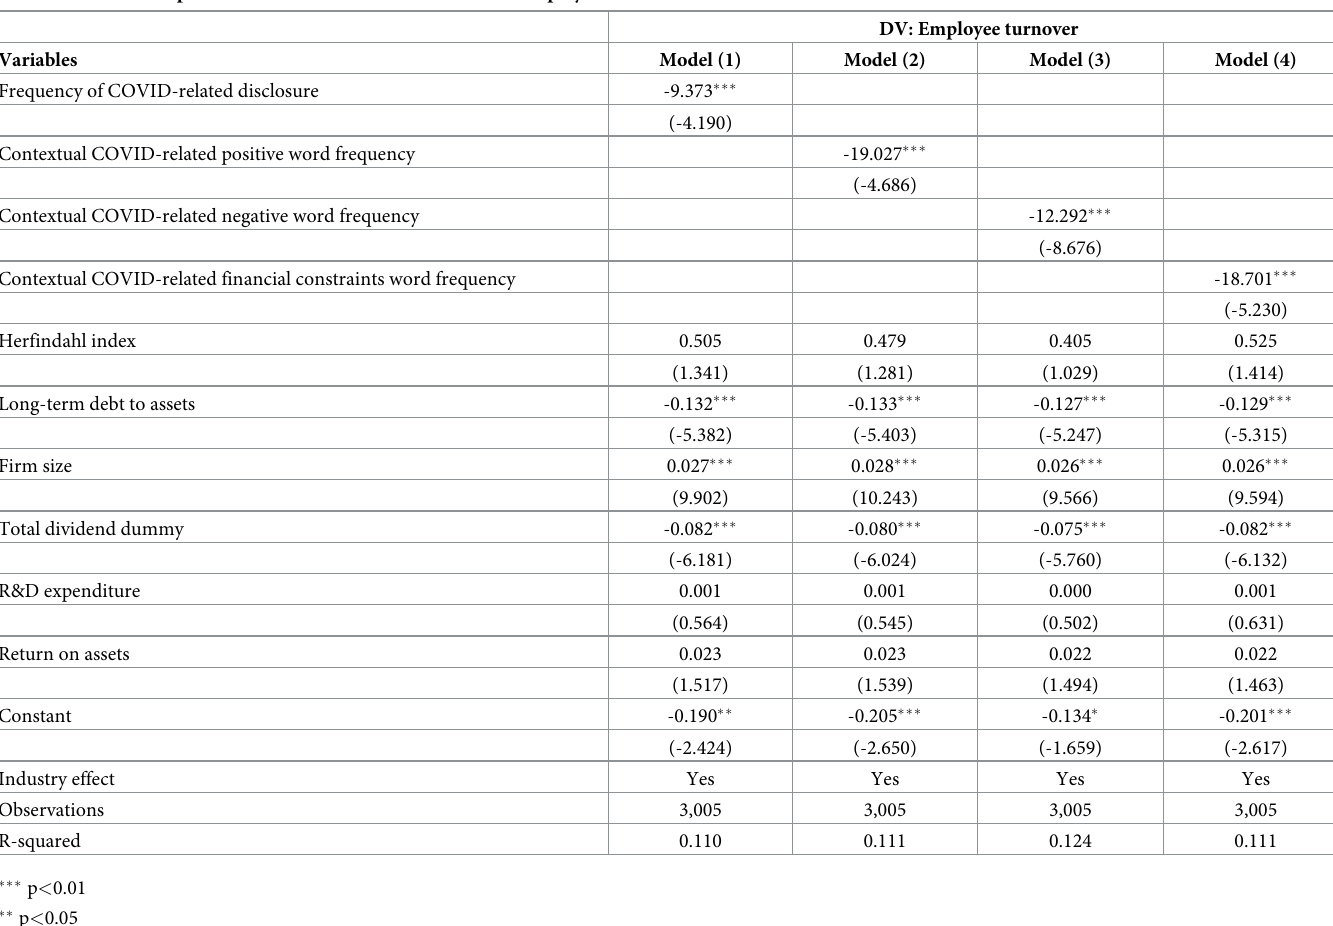
Table 12. Relationship between COVID-related disclosure and employee